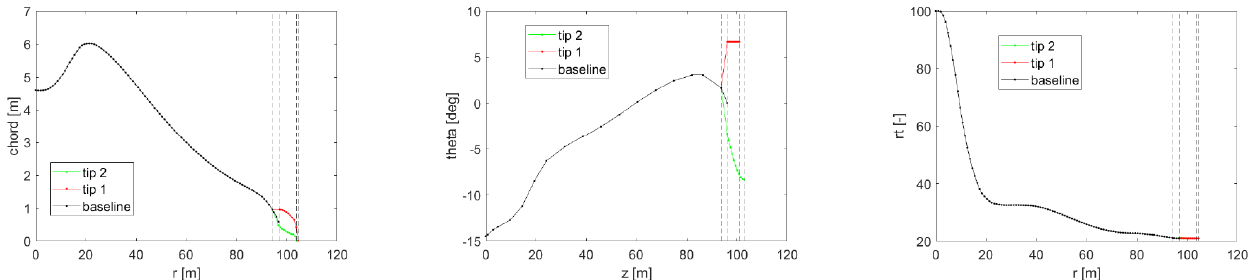
Figure 1. Planform for two reference tips at the borders of the design space. Vertical dashed lines indicate the location of the control points.